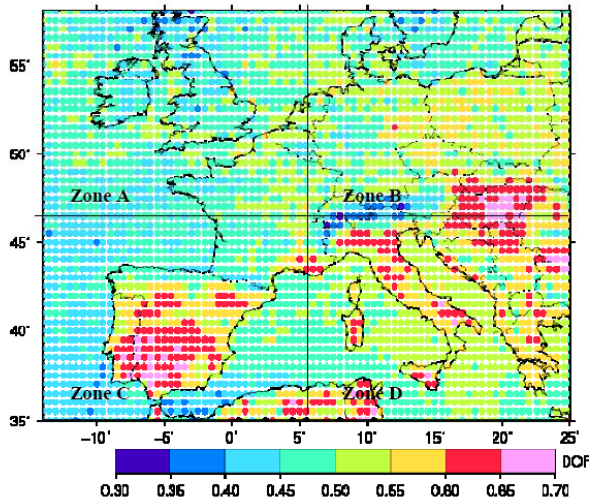
Fig. 2. Monthly mean of Degrees of Freedom (DOF) for the IASI data (0–6km columns) used in the study (blue color represents rela- tively low values; pink color represents relatively high values). The domain was split in four zones: zone A for North-West, zone B for North-East, zone C for South-West and zone D for